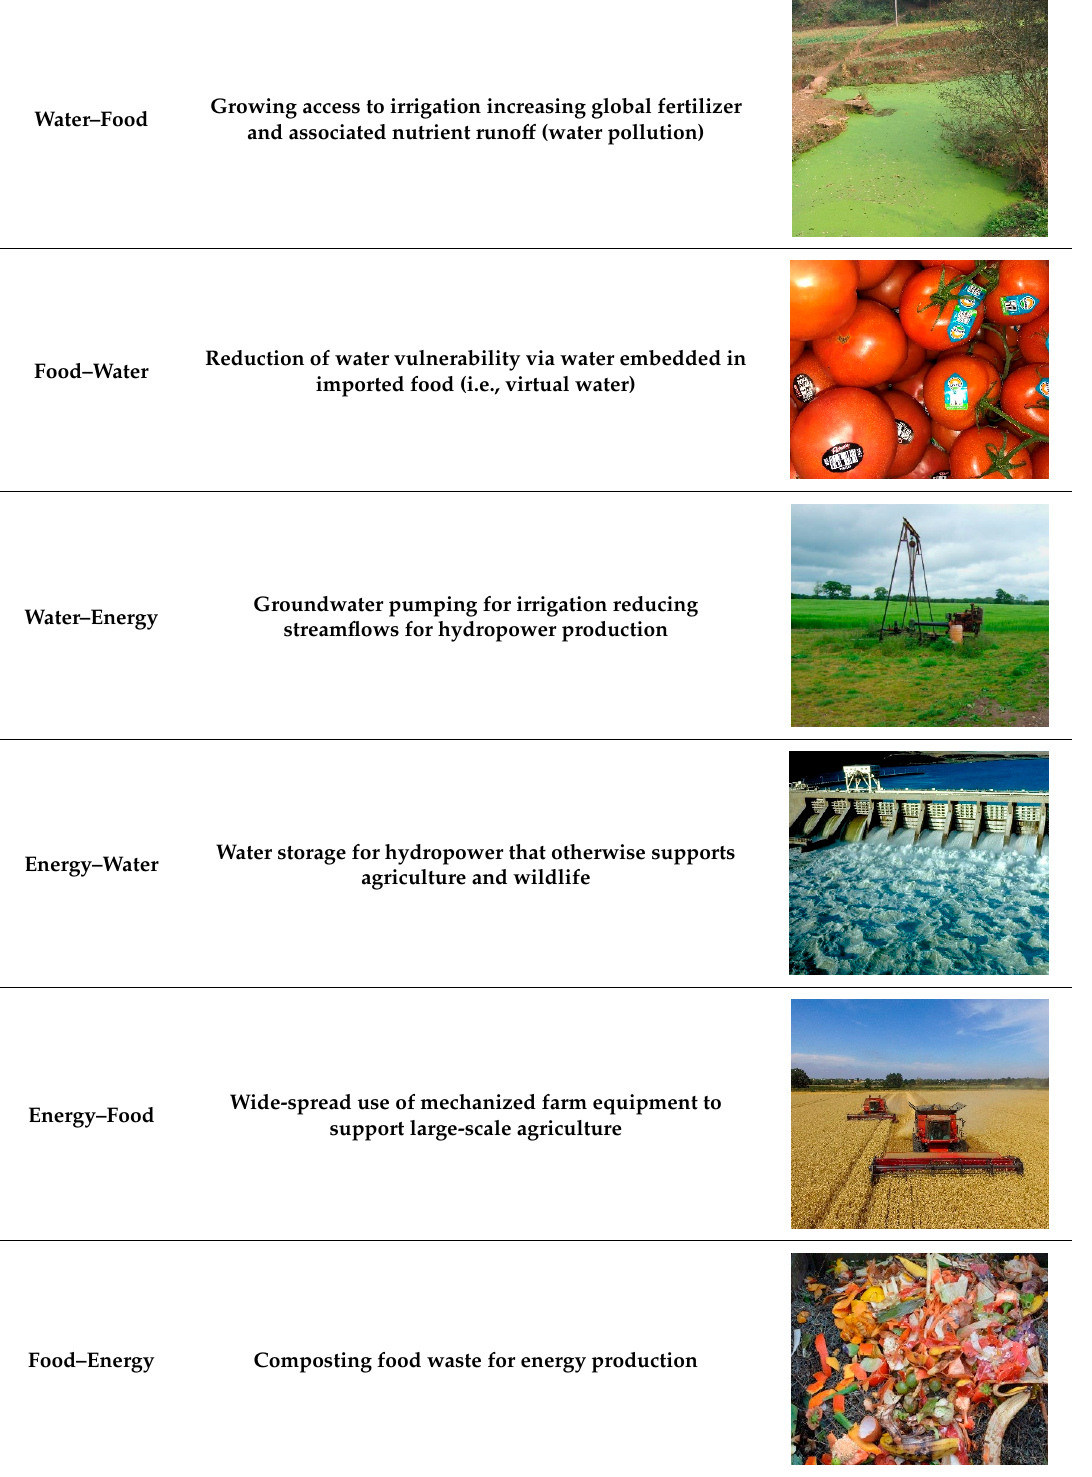
Table 1. Examples of complex transactions at FEW sector boundaries that may manifest the complex dependencies, either positive or negative, across FEW sectors. These examples may not manifest at every FEW sector boundary, but do illustrate the potential degree of complexity. Photos: Algal bloom, CC-BY-3.0 Felix Andrews; Internationally sourced tomatoes, Stephen Katz; Groundwater pumping, CC-BY-SA-3.0 John Poyser; McNary Dam on the Columbia River USA, public domain from US Department of Energy; Combine harvesters, Ryan Archer from Pexels; Composting vegetables, open source by Ben Kerckx.